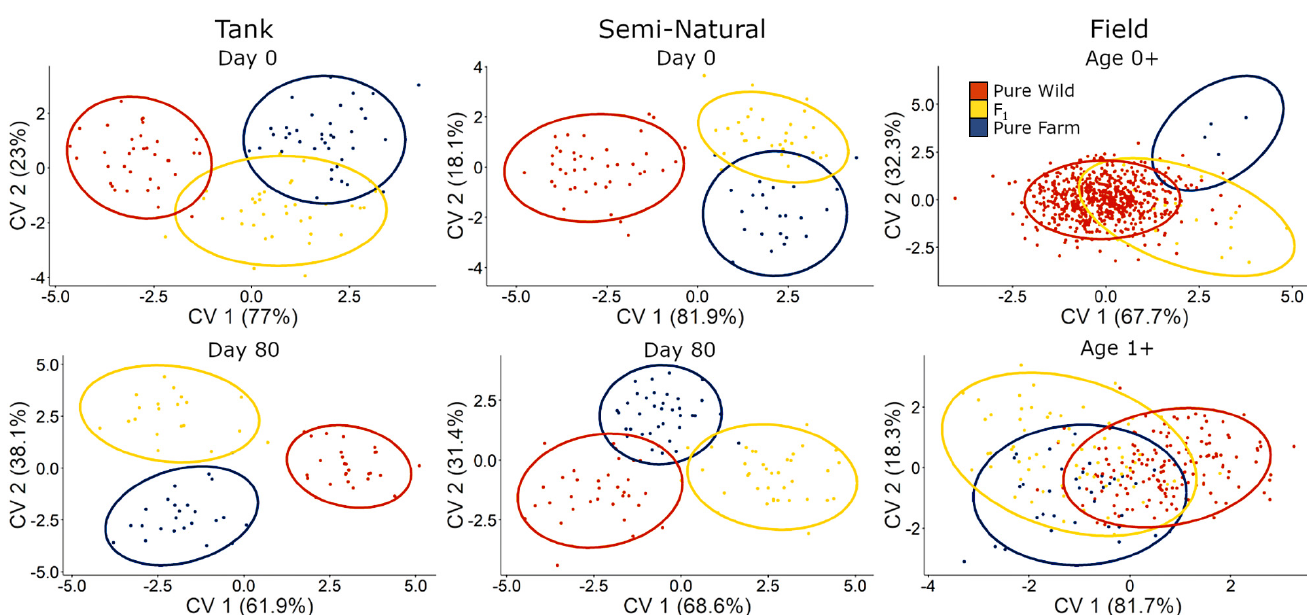
Fig. 3. Canonical variate analysis of landmarks after Procrustes alignment with 95% confidence ellipsis for each cross type. For the common garden experiment, shape is shown for Day 0 (start) and Day 80 (end) post yolk absorption. Juveniles aged 0+ (young of year) and 1+ were sampled from field locations (18 southern Newfoundland rivers; Fig. 1). Identification of cross type of field-sampled individuals was accomplished using genetic assignment and is described in Section